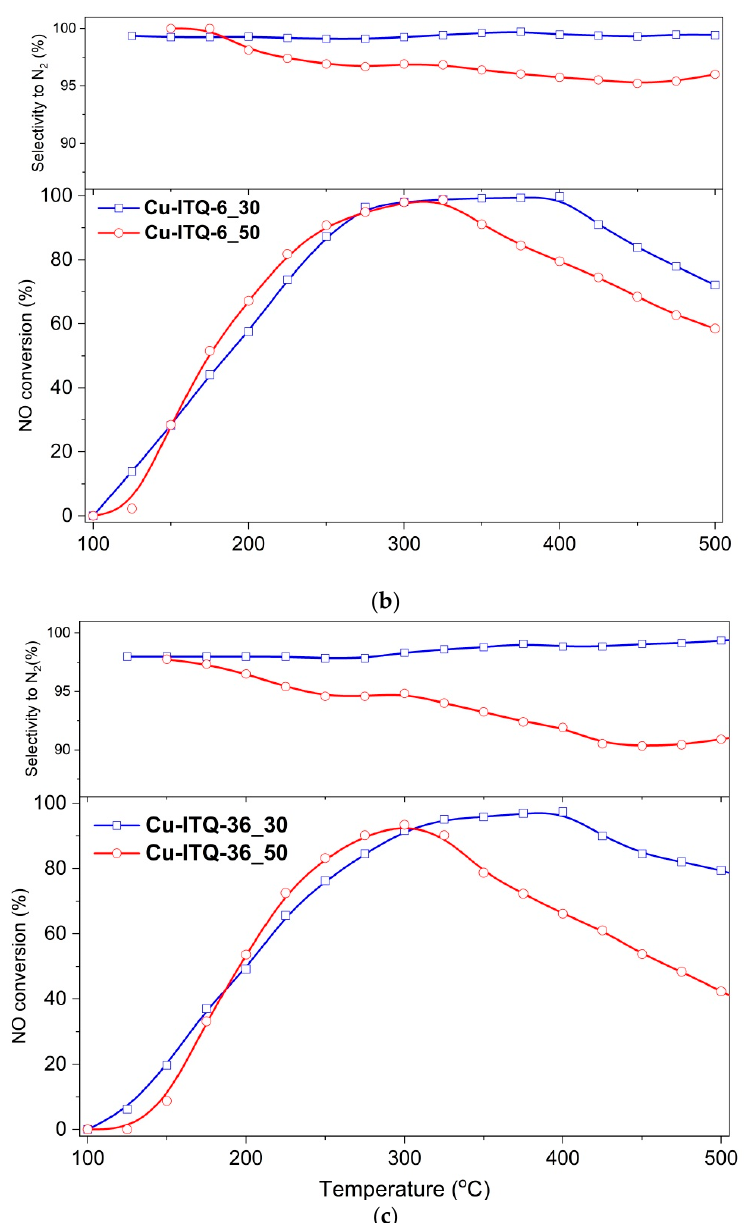
Figure 7. Results for catalytic NH 3 -SCR tests for FER ( a ), ITQ-6 ( b ) and ITQ-36 ( c ) samples modified with